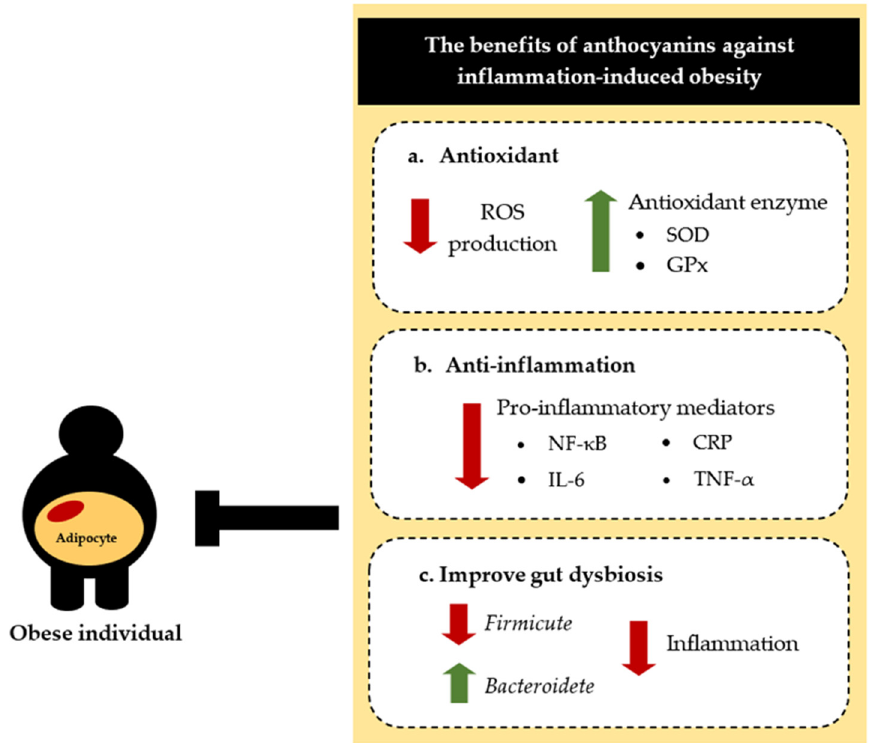
Figure 4. The anti-obesity effects of anthocyanins. ( a ) Anthocyanins are antioxidants that eliminate reactive oxygen species (ROS) by increasing antioxidant enzymes such as superoxide dismutase (SOD) and glutathione peroxidase (GPx). ( b ) Anthocyanins prevent nuclear factor kappa B (NF- κ B) activation, thus decreasing the entire downstream cascade of pro-inflammatory mediators such as C-reactive protein (CRP), interleukin (IL)-6, and tumor necrosis factor (TNF)- α . ( c ) Anthocyanins also improve gut dysbiosis, restoring a balanced gut microbiota.